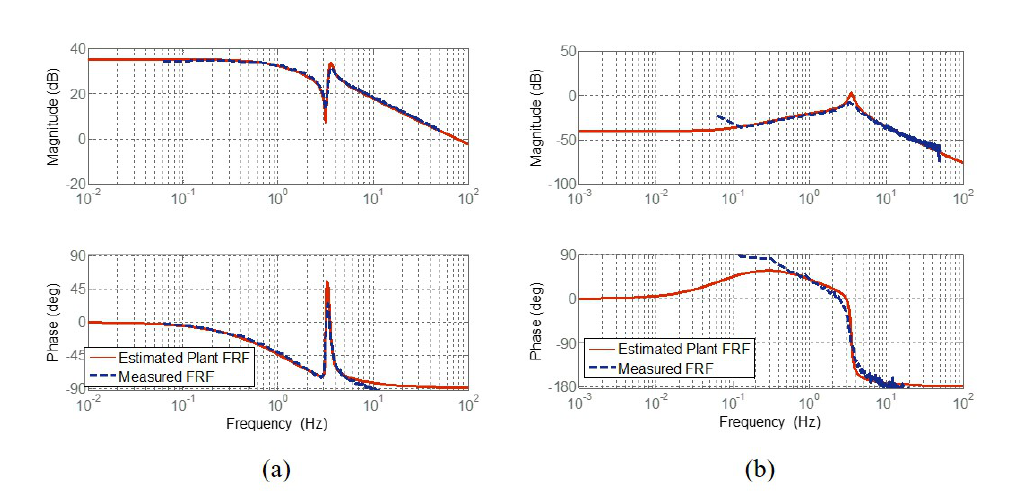
Figure 17. Frequency Response Functions of cPEA [15]. ( a ) FRFs from motor torque to motor velocity and ( b ) FRFs from motor torque to spring deformation.